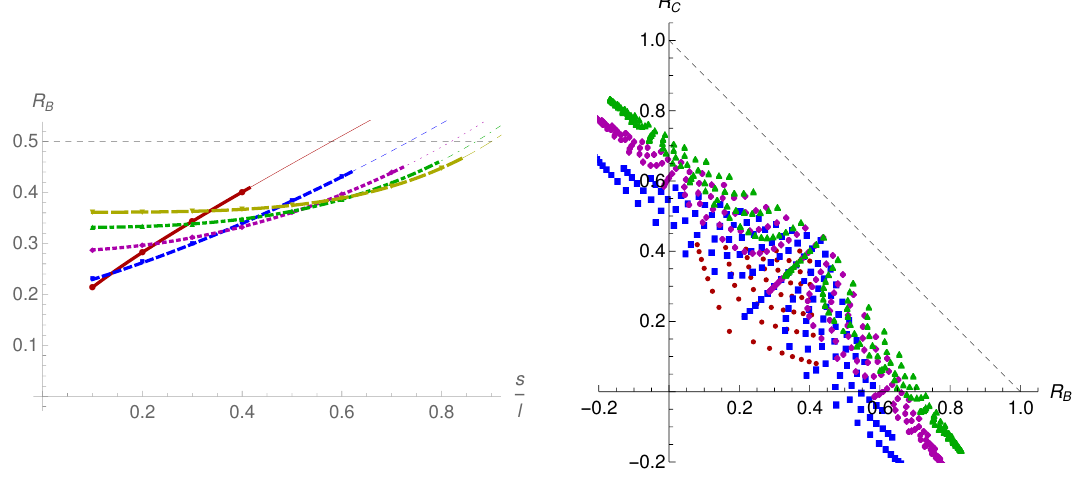
Figure 12 . Demonstration of weak monogamy for pure AdS d +1 geometries. Left : the ratio for the symmetric configuration as a function of s/l . Right : the ratio for the asymmetric configuration with different s and s . Color scheme used here is similar to figure 1 2